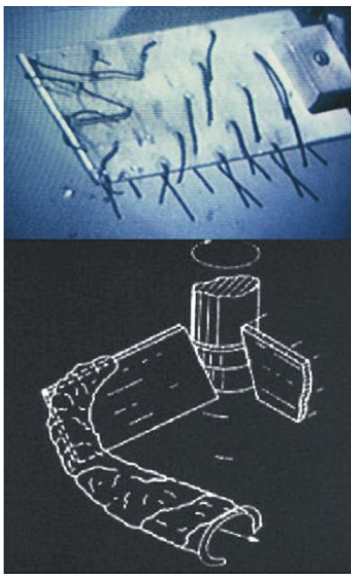
Figure 4: Pitched blade impeller vortex.